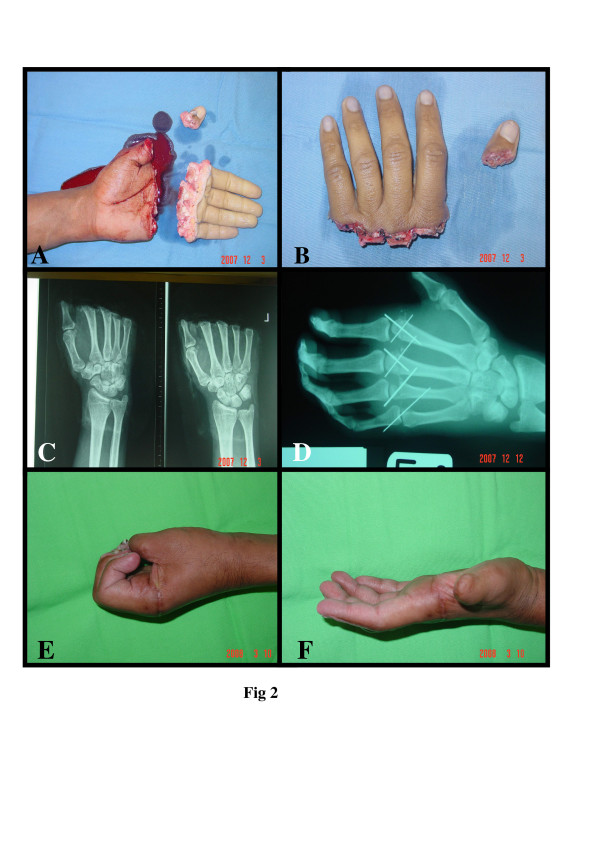
Selection of teams.